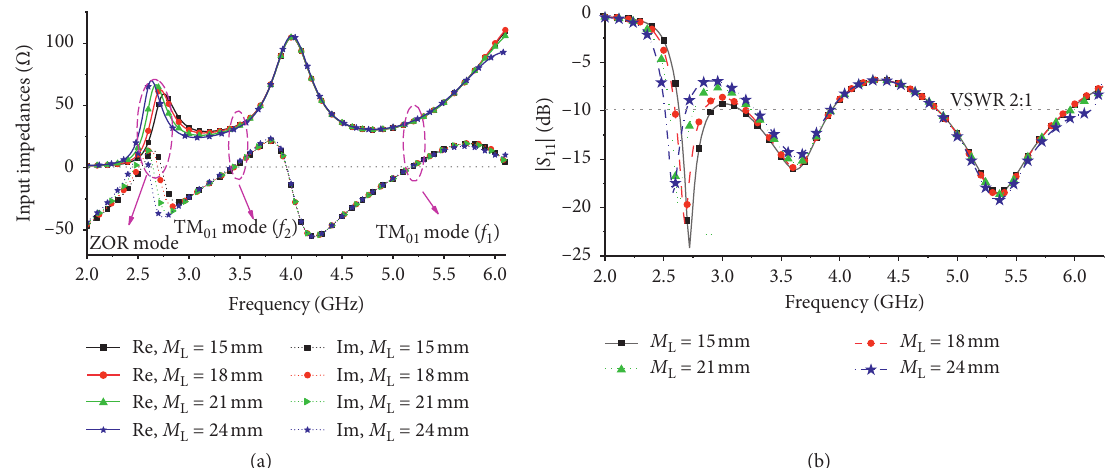
Figure 8: The effect of M L on (a) input impedances and (b)| S 11 | of the proposed patch antenna.